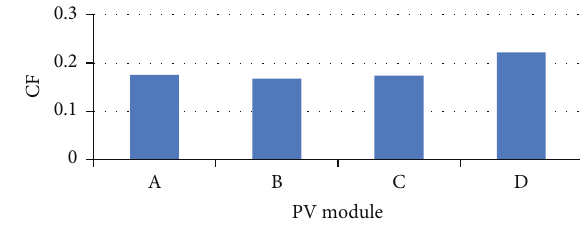
Figure 2: CF of the PV module.